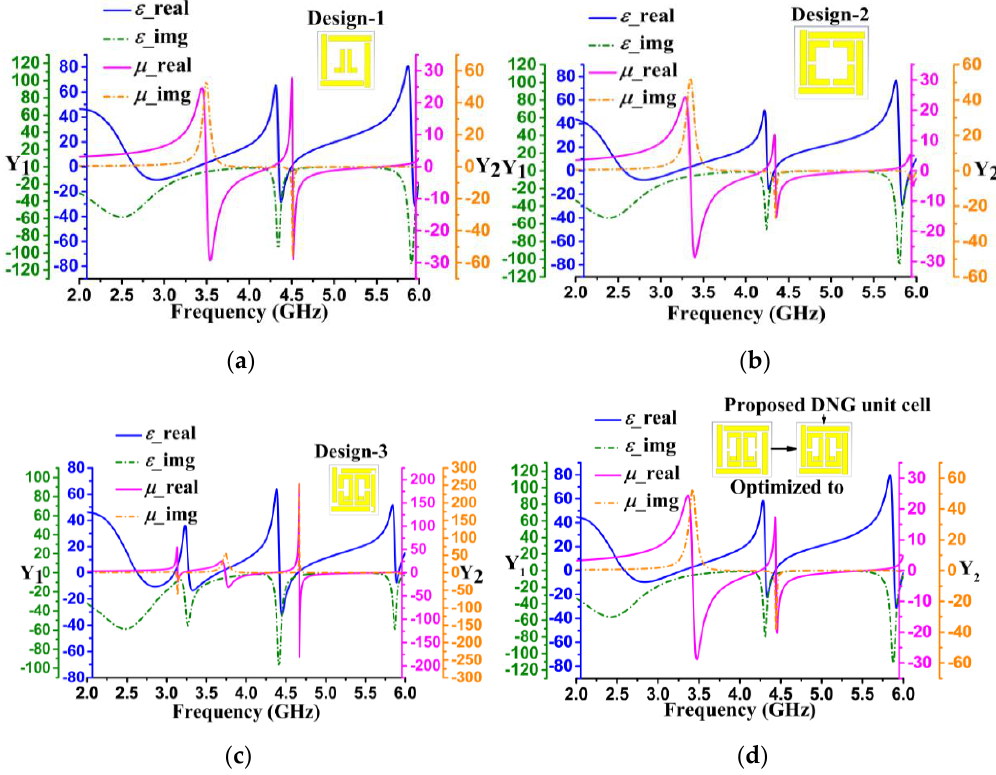
Figure 3. Metamaterial DNG unit cell geometry evolution and dielectric performance in the simulation for ( a ) Design-1, ( b ) Design-2, ( c ) Design-3, and ( d ) the optimized DNG unit cell. Y 1 and Y 2 respectively represent the two vertical axes for permittivity and permeability.